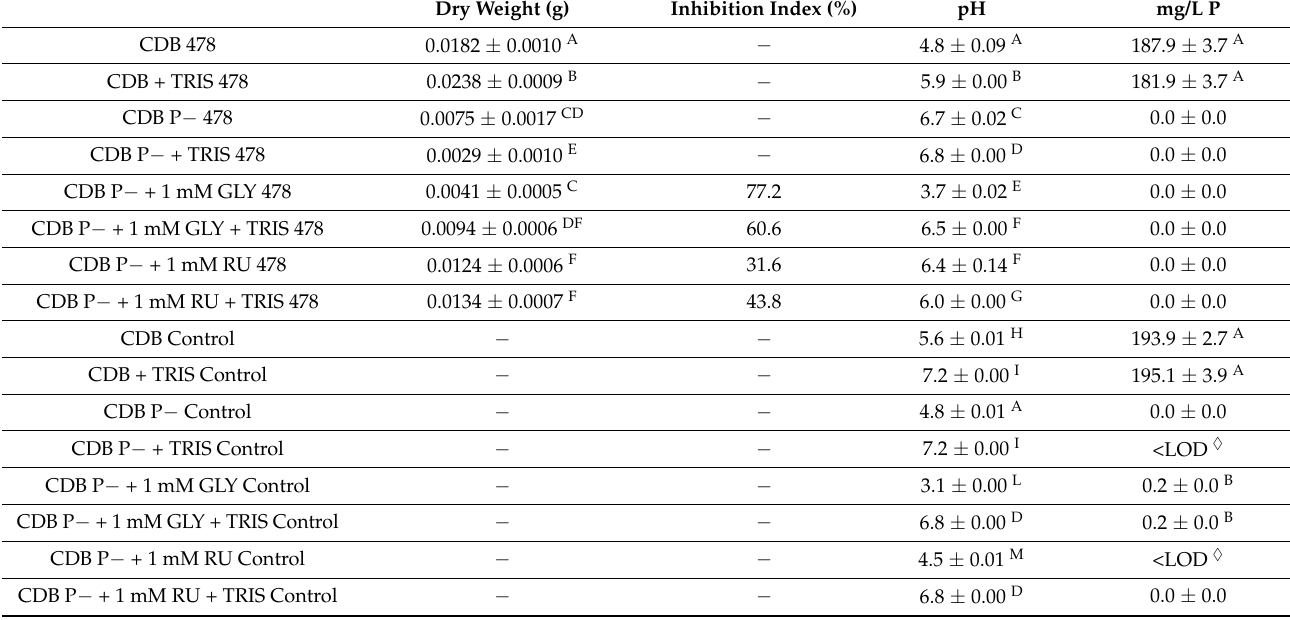
Table 8. Values of dry weights, inhibition index, medium pH, and P concentration after fungal growth for 2 weeks at 25 ◦ C in different cultural conditions with or without tris(hydroxymethyl)aminomethane (TRIS) buffer. The data are expressed as the mean ± standard error of independent replicates a